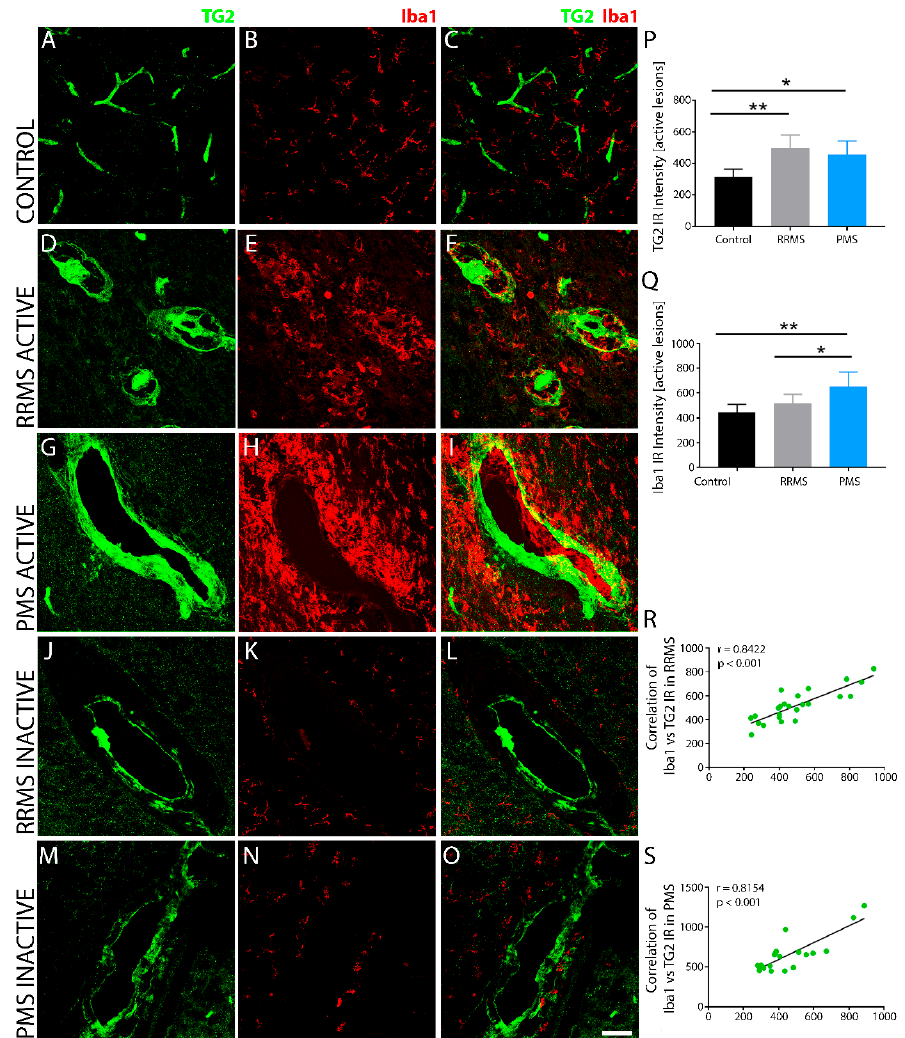
Figure 2. TG2 immunoreactivity is significantly upregulated in active lesions of MS brain tissue. Compared to non ‐ MS brain tissue ( A – C ), which exhibited low basal levels of TG2 expression ( A , C ) and a sparse population of Iba1+ immune cells ( B ), TG2 expression was robustly increased in active lesions of both RRMS ( D , F ) and PMS ( G , I ). A dense cellular immunoreactivity for Iba1+ activated microglia and macrophages was also observed in and around the lesions ( E , H ). TG2 and Iba1 ‐ posi ‐ tive immune cell density were both significantly lower in inactive lesions of both RRMS ( J – L ) and PMS ( M – O ). Quantitative assessment of TG2 ( P ) and Iba1 ( Q ) immunoreactivity in active lesions of RRMS and PMS brain tissues revealed significantly increased expression levels compared to non ‐ MS brain tissue. A positive linear correlation was observed between TG2 immunoreactivity and the density of Iba1 ‐ positive immune cells surrounding active lesions in both RRMS ( R ) and PMS ( S ). Scale bar = 40 μ m. Data were quantified and expressed as value of the mean plus the standard de ‐ viation (SD). Statistical significance indicated a * p < 0.05; ** p < 0.01, determined using a 1 ‐ way analysis of variance and post hoc Tukey test. The correlation between the immunodensity of Iba1 and TG2 IR in the lesions from all the patients in each of the two forms of MS is shown in ( R ) and ( S ). The p ‐ value determined by linear regression and Pearson correlation coefficient (r) is indicated for each of the analyses.